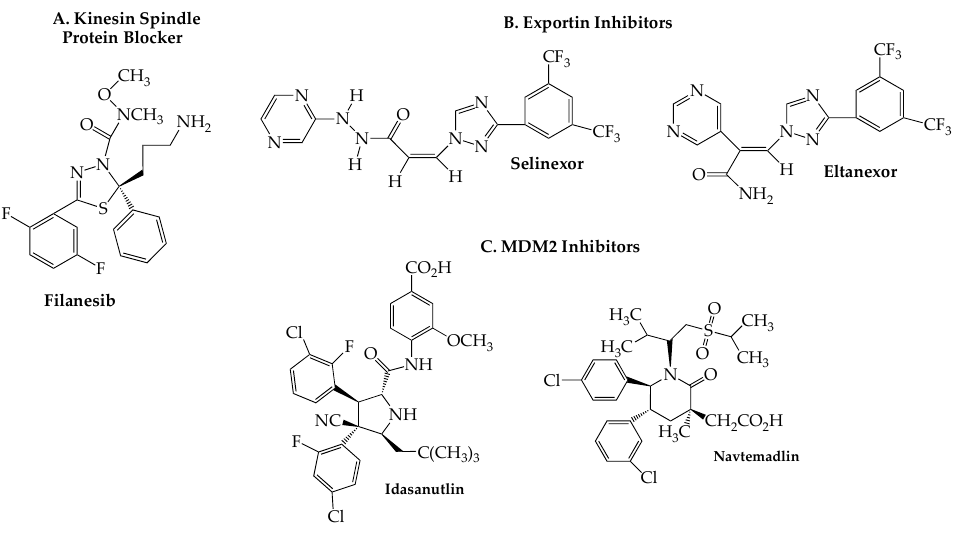
Figure 6. Structural Formulas of Additional Small Molecules with Activity Against MM. Table 5. Clinical Trials of Filanesib in RRMM.